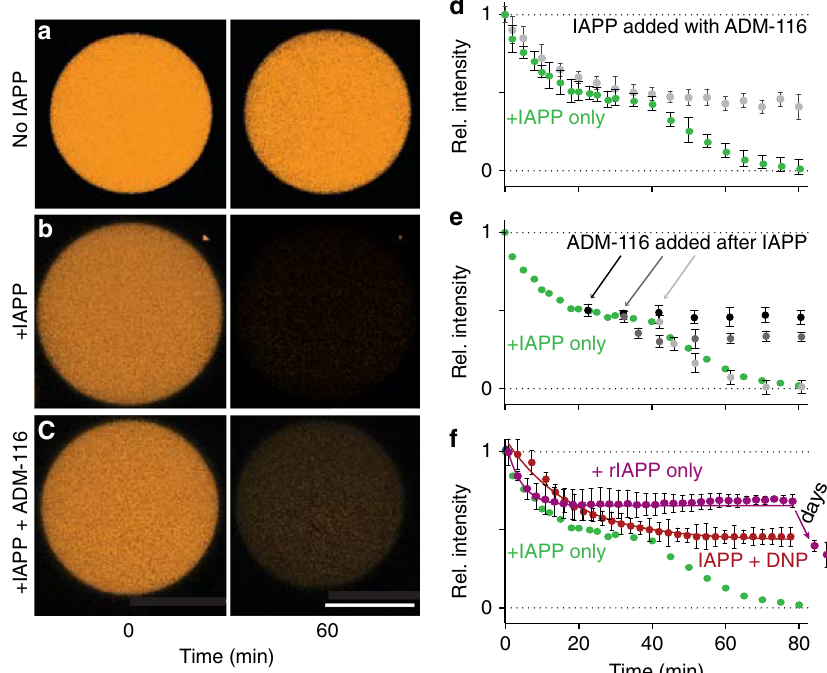
Fig. 1 IAPP induces poration in a cell derived membrane. a – c Representative confocal images of CellTracker Orange labelled GPMVs at the indicated time points. Shown are single GPMVs observed without added IAPP a , IAPP added to a ratio of 10:1 (IAPP:lipid), b and IAPP added in the presence of ADM-116 to a ratio of 10:1:10 (IAPP:lipid:ADM-116), c . d Integrated intensities across repeats of data as in a – c used to determine kinetic pro fi les of leakage from 5 μ M (phospholipid monomer units) GPMVs. e Leakage pro fi le at 50 μ M IAPP in the presence of equimolar ADM-116 added at the indicated delayed time points. f Leakage pro fi les upon addition of 10 μ M DNP or 200 μ M of the sequence variant of IAPP from rats, rIAPP. Con fi dence intervals are standard deviations from pairs of experiments conducted on three separate occasions, i.e., n = 6. Corresponding data for human " + IAPP only" in e and f are shown as an overlay without con fi dence intervals. Scale bar for all images is 20 μ